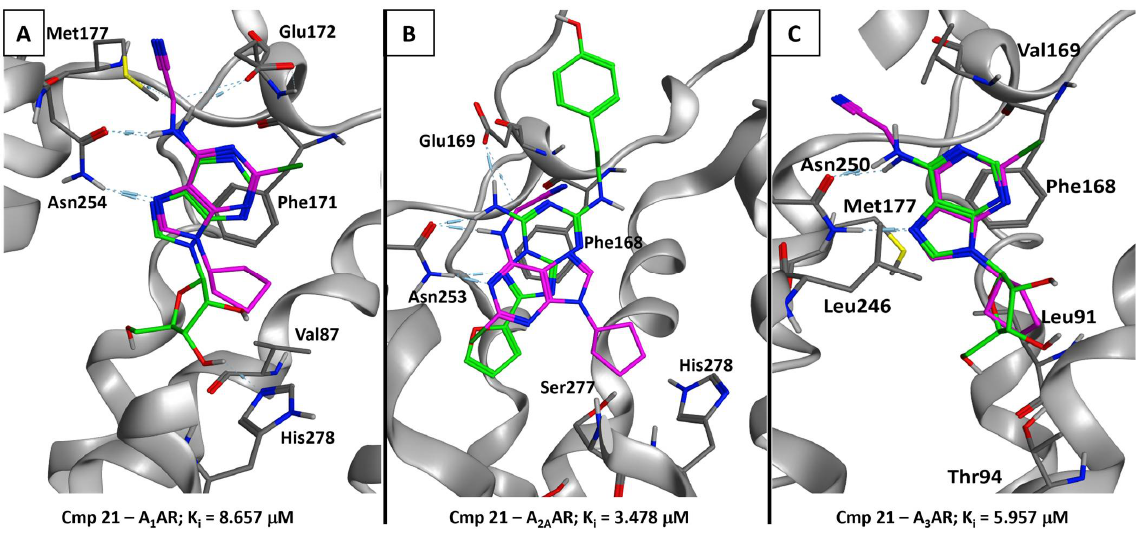
Figure 5. Representation of the three binding modes of compound 21 in complex with, respectively, the A 1 AR (panel ( A )), A 2A AR (panel ( B )), and A 3 AR (panel ( C )). In each image, the reference compound is colored light green (Ado for A 1 AR and A 3 AR; ZMA for A 2A AR), while compound 21 is purple. The main residues surrounding the ligands in the binding site are labeled, and the hydrogen bonds are represented with dashed lines. All of the images were created and rendered with MOE.